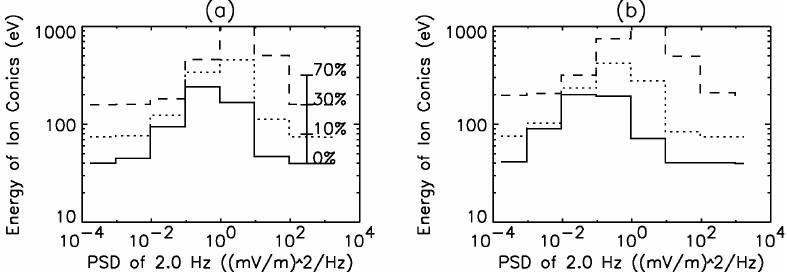
Fig. 4. Relationship of energy of perp. (a) and non-perp. (b) conics to power spectral density of LEFs. Format is same as that used in Fig. 3.